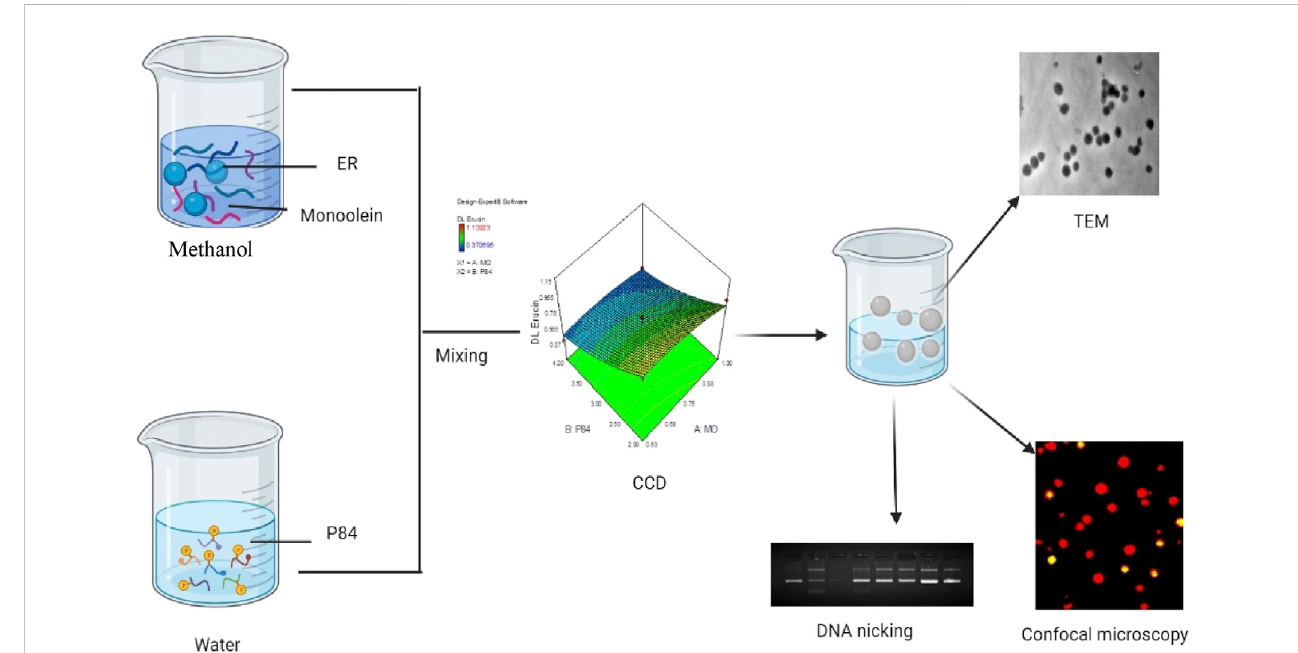
FIGURE 1 Schematic representation of preparation of ER loaded Cubosomes (ER-CUB) and in vitro cytotoxitity studies.